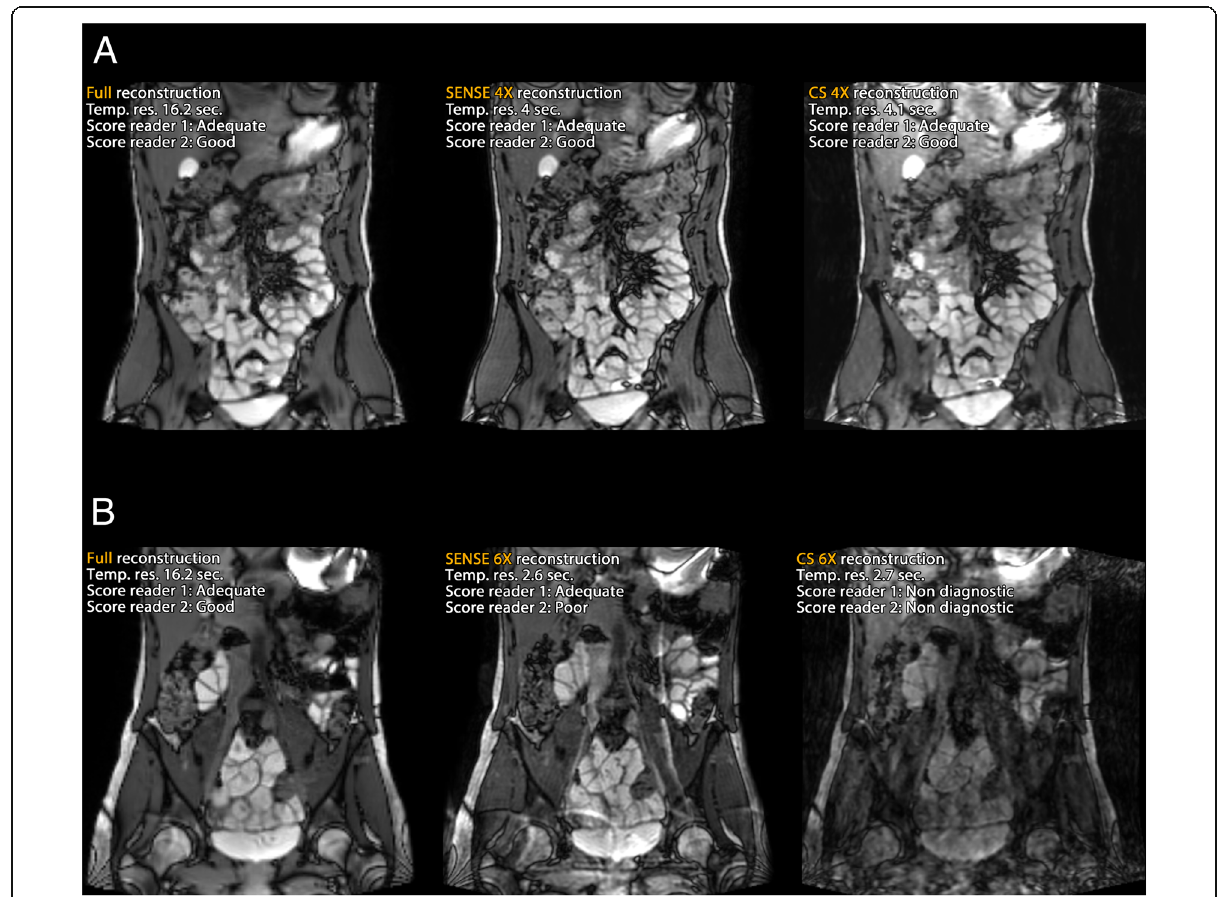
Fig. 7 Two scored datasets showing fully sampled three-dimensional balanced fast field-echo reconstructed data (left), sensitivity encoding (SENSE) reconstructed data (middle) and compressed sensing and parallel imaging (CS-PI) reconstructed data (right). The upper set ( a ) was 4× accelerated. All scans were scored adequate or good for diagnostic purpose. The lower set ( b ) was 6× accelerated; in this case, CS-PI reconstruction was scored as